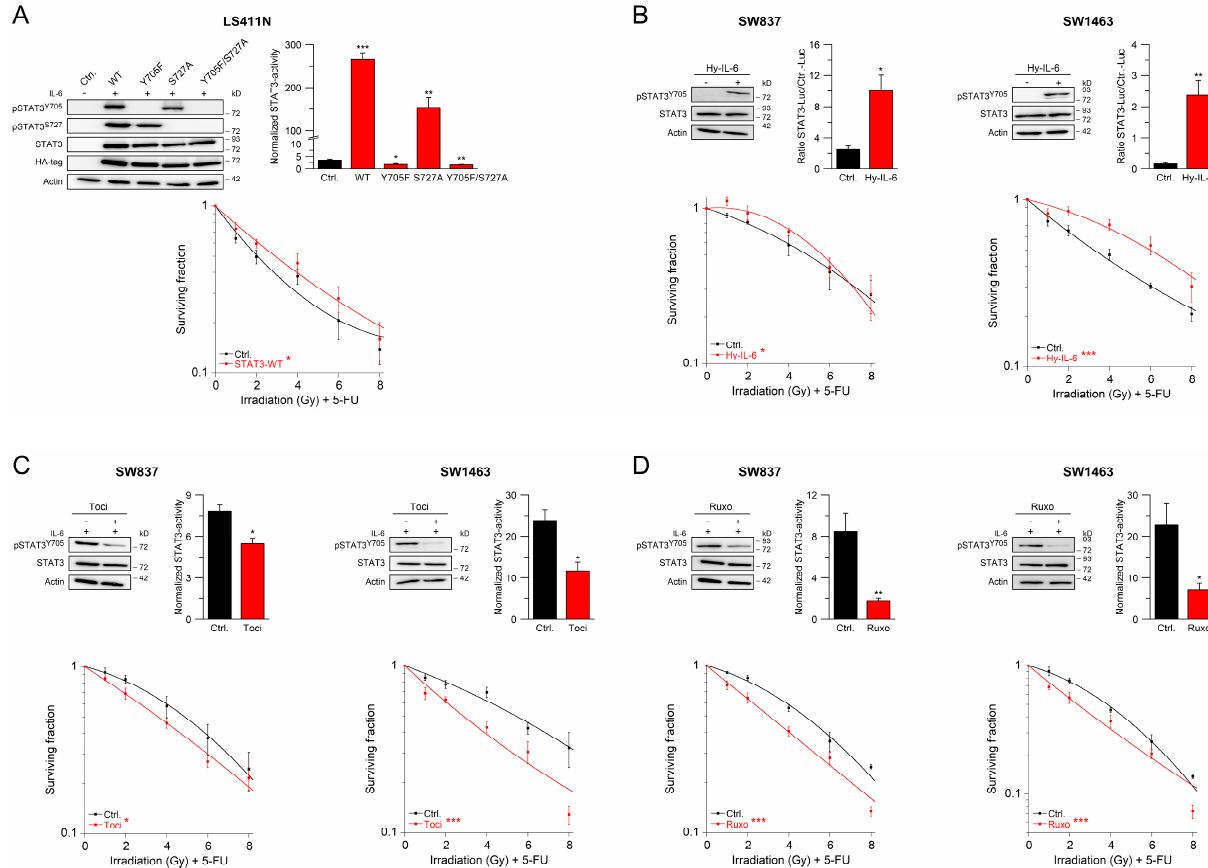
Figure 1. Cytokine receptors of the gp130 family regulate CRT sensitivity via STAT3 activation. ( A ) STAT3-negative LS411N cells were transfected with empty control vector or constructs encoding HA-tagged versions of wild-type STAT3 or STAT3 variants harboring indicated amino acid exchanges. Cells were analyzed for expression and inducible phosphorylation of STAT3 proteins by immunoblotting (upper left) or monitored for inducible STAT3 transcriptional activity (upper right), or were cultured in colony formation assays (CFA) to measure their survival following irradiation in the presence of 5-FU (CRT) (lower graph). ( B ) Hyper-IL-6 (Hy-IL-6)-induced STAT3 phosphorylation and transcriptional activity were analyzed in STAT3-positive SW837 or SW1463 cells (upper panels), and the impact of that stimulation on sensitivity to CRT was assessed (lower panel). ( C , D ) cells were treated with ( C ) tocilizumab (Toci) or ( D ) ruxolitinib (Ruxo) and analyzed for STAT3 functionality as described above or were monitored for CFA survival after CRT. Data presented as mean ± s.e.m. from at least n = 3 independent biological replicates. * p < 0.05, ** p < 0.01, *** p < 0.001, unpaired two-sample